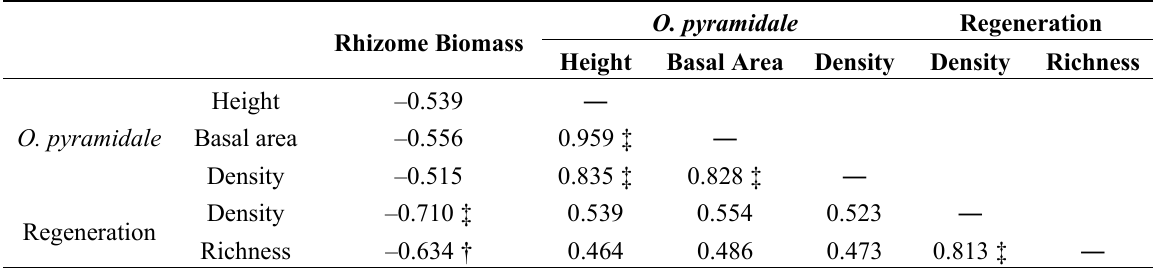
Table 3. Spearman partial correlation coefficients among bracken rhizome biomass, Ochroma pyramidale attributes (height, basal area, and density), and regeneration attributes (density and species richness) after controlling for the correlated effects of other predictor variables. ‡: p < 0.01, †: p < 0.05. O. Rhizome Biomass